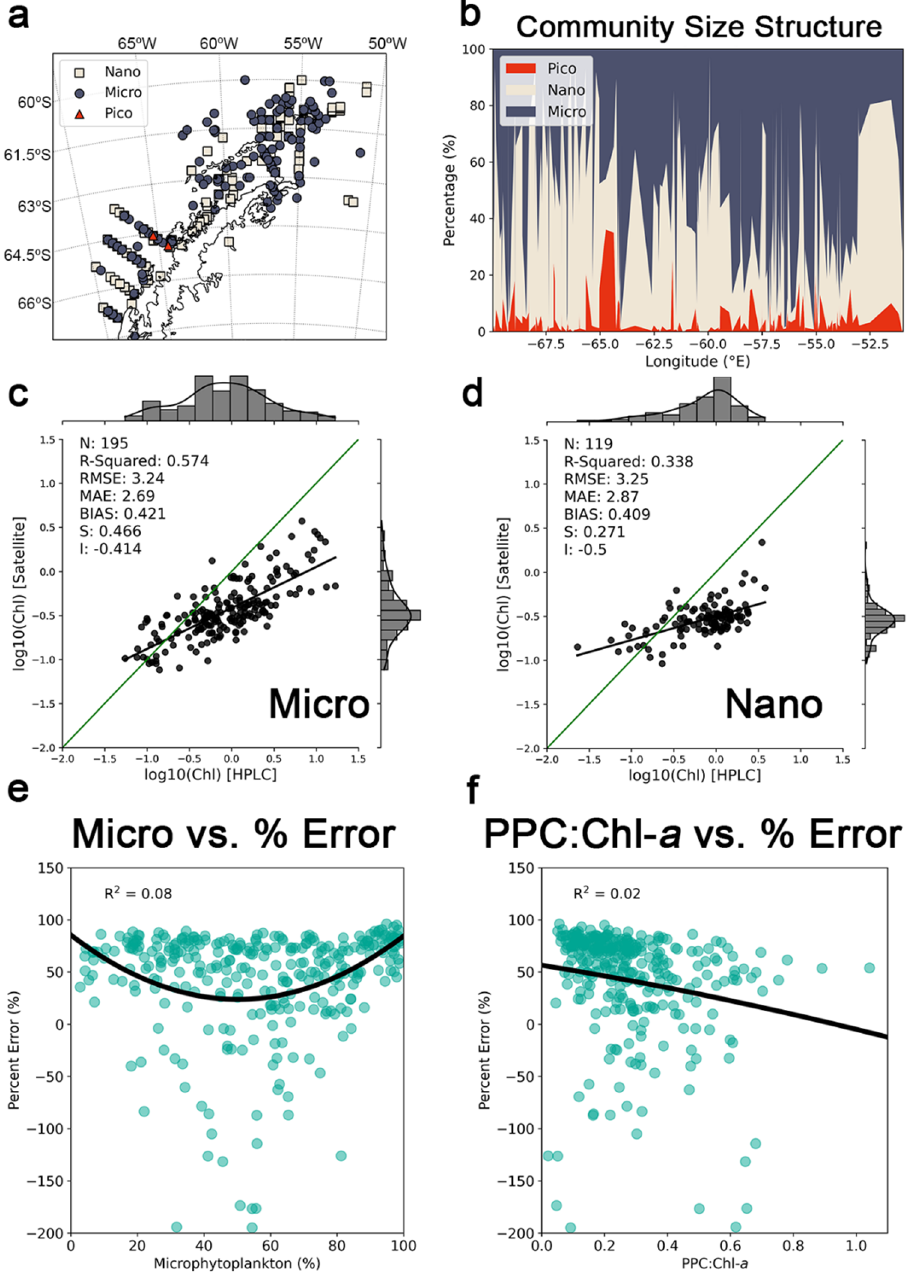
Figure 5. Top row: dominant phytoplankton size class ( a ) and pico-, nano- and microphytoplankton relative percentage ( b ) for the match-ups identified. Mid row: CCI 4.2 Chl- a product performance for match-ups dominated by microplankton ( c ) and nanoplankton ( d ). The green line represents the 1:1 line (ideal correspondence). Bottom row: relationship between the percent error (i.e., the percentage of the difference between in-situ Chl- a and satellite-derived Chl- a ; %) and the percentage of microphytoplankton ( e ) and the ratio between the protective carotenoids and Chl- a ( f ).